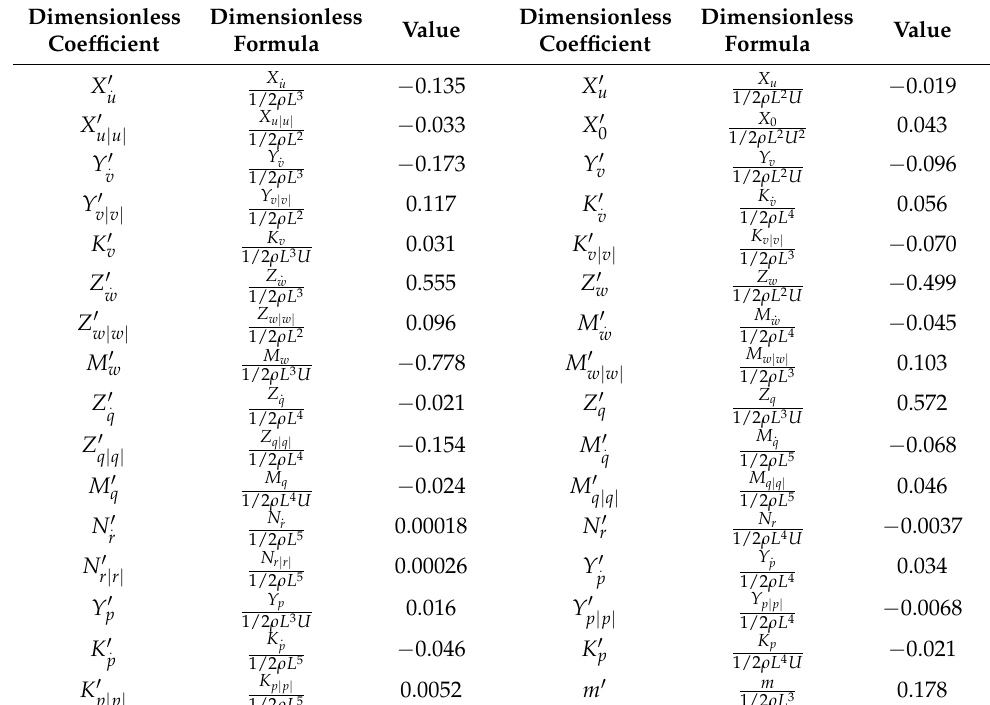
Figure 11. Simulation results of harmonic sway are fitted by MATLAB: ( a ) transverse force; ( b ) yaw moment. Table 2. Dimensionless hydrodynamic coefficient of